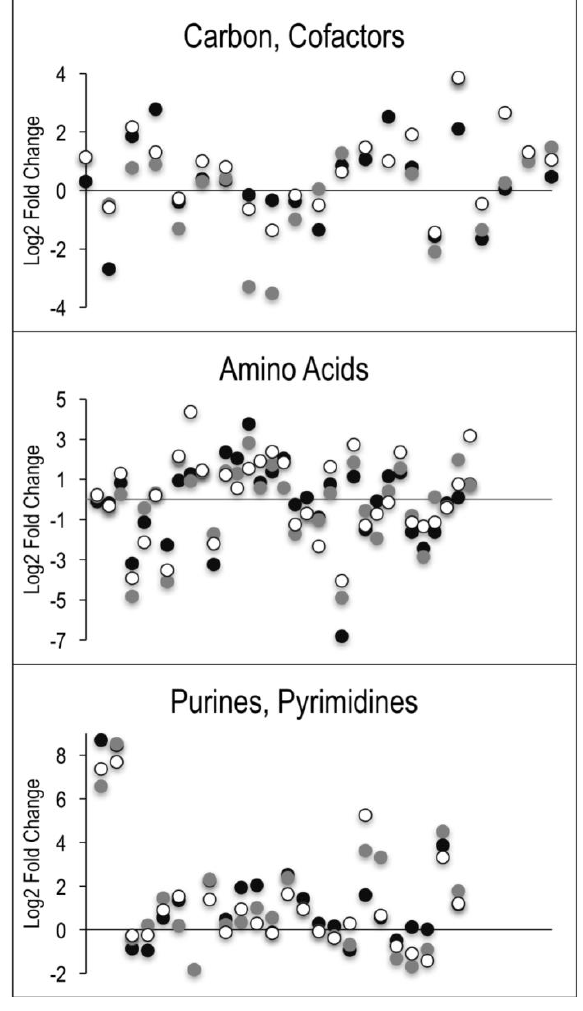
FIGURE 4: AICAR perturbs various areas of metabolism. Untar- geted metabolomics was performed on wild-type and purH mu- tant of S. enterica grown in glucose minimal medium supplement- ed with adenine and thiamine. Relative concentrations of metabo- lites were determined by calculating the ratio of the average MS ion intensities (peak areas) in wild-type and purH strains ( purH /WT). Here the log transformed fold changes (Log2) of me- tabolites with statistically significant differences were plotted to distribute the decreases and increases (below and above) the y- axis. Each point along the x-axis represents a metabolite. Each of 3 experimental replicates are differentiated by color. Specific me- tabolites, fold changes and p-values are provided in Table